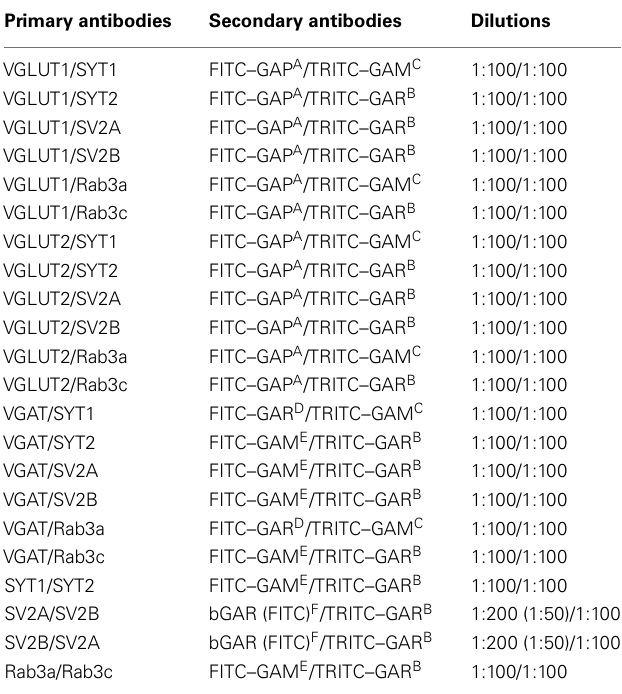
Table 2 | Dilutions of antibodies in double-labeling